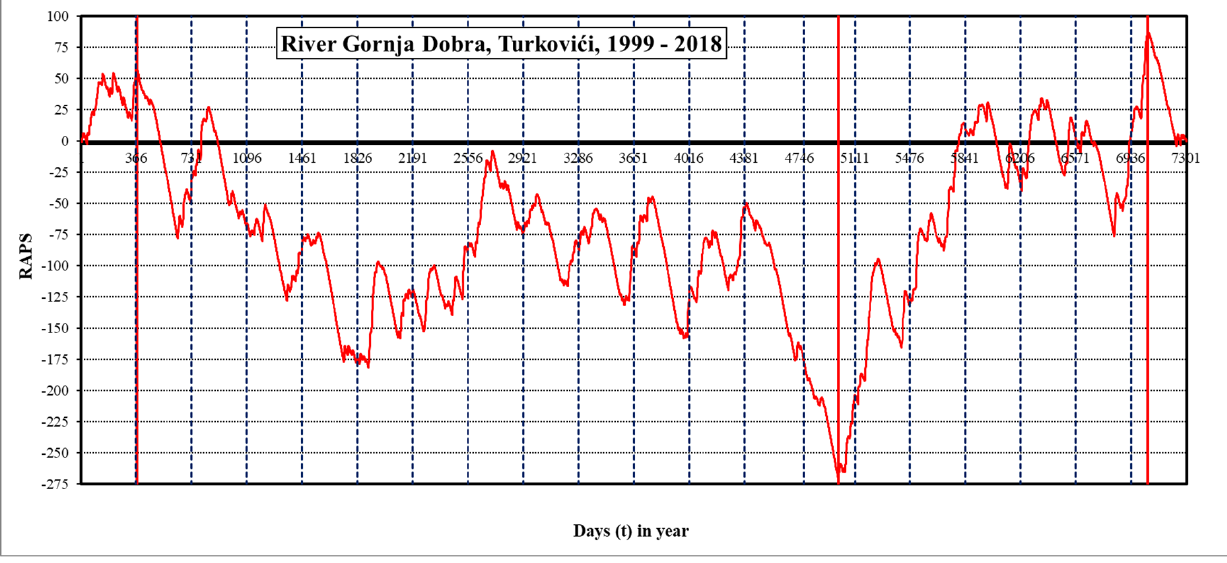
Figure 5. RAPS diagram for the river Gornja Dobra.